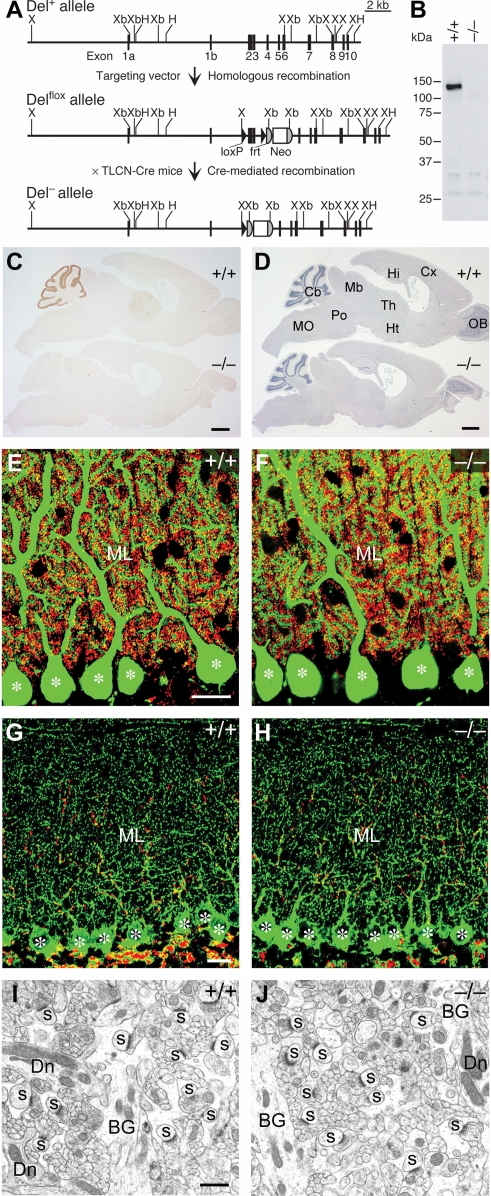
Generation and cerebellar structure of mutant mice lacking Delphilin.A, Schema of the Delphilin gene (Del+), floxed allele (Delflox), and null allele (Del−). Exon 3 encodes the PDZ domain of Delphilin. The Delflox allele contains two loxP sequences flanking exon 2 and 3 of the Delphilin gene and the neo gene flanked by two frt sequences. Del+/− mice were obtained by crossing Del+/flox mice with TLCN-Cre mice. Neo, neomycin phosphotransferase gene; H, HincII; X, XhoI, Xb, XbaI. B, Western blot analysis of Delphilin in cerebellar homogenates. C, Immunohistochemical analysis of Delphilin in the parasagittal brain sections. D, Hematoxylin staining of the parasagittal brain sections. Cb, cerebellum; Cx, Cerebral cortex; Hi, hippocampus; Ht, hypothalamus; Mb, midbrain; MO, medulla oblongata; OB, olfactory bulb; Po, pons; Th, thalamus. E,F, Double immunofluorescence for calbindin (green) and VGluT1 (red) in the cerebellar molecular layer of wild-type (E) and mutant (F) mice. Asterisks indicate the cell body of PCs. ML, molecular layer. G,H, Double immunofluorescence for VGAT (green) and VGluT2 (red) in the cerebellar molecular layer of wild-type (G) and mutant (H) mice. Asterisks indicate the cell body of PCs. ML, molecular layer. I,J, Electron micrographs of the cerebellar molecular layer of wild-type (I) and mutant (J) mice. BG, Bergmann glia; Dn, PC dendrite; s, PC spine in contact with PF terminals. Scale bars: C,D, 1 mm; E,G, 20 µm; I, 1 µm.